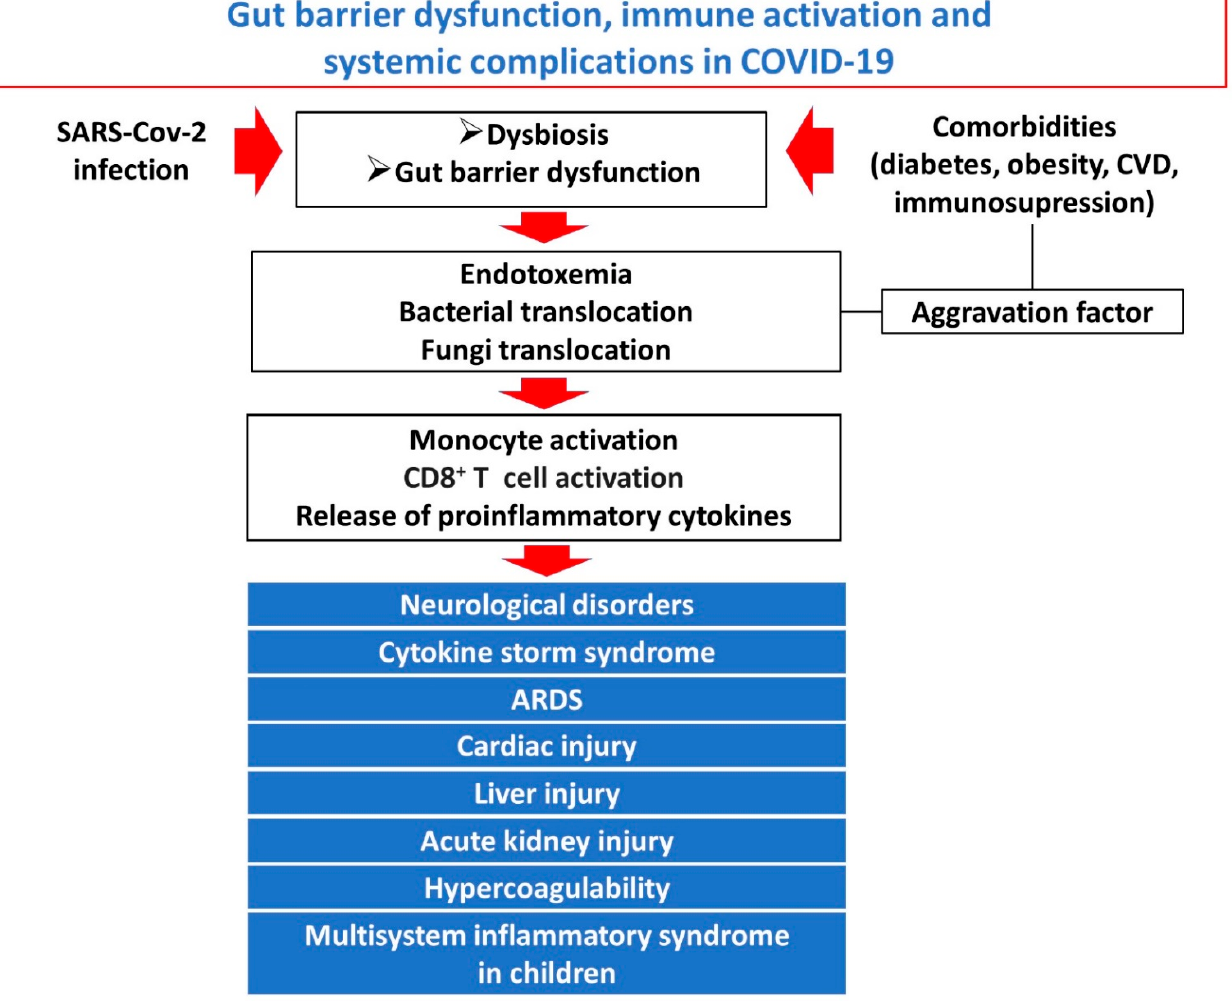
Figure 2. Overview of the interconnection between gut barrier dysfunction, bacterial and endotoxin translocation, immune activation and systemic complications of severe COVID-19: the dysfunctional gut barrier in SARS-CoV-2 infection permits the escape of luminal bacteria, fungi and endotoxin to normally sterile extraintestinal sites and the systemic circulation. Pre-existing gut barrier dysfunction and endotoxemia in patients with comorbidities such as cardiovascular disease, obesity, diabetes and immunosuppression predisposes to aggravated endotoxemia. Bacterial and endotoxin translocation induce monocyte and CD8+ T cell activation and release of proinflammatory cytokines. Systemic inflammation and immune activation characterize the SARS-CoV-2 induced “viral sepsis” syndrome, which is associated with multisystemic complications of severe COVID-19.